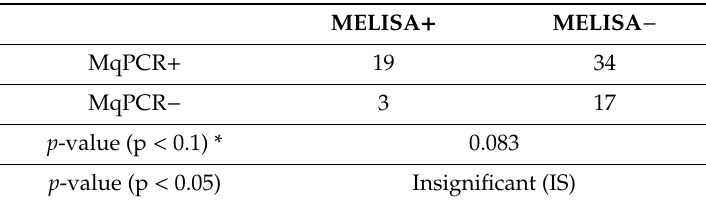
Table 5. Distribution of 73 BTMs based on the positivity / negativity status in MqPCR and MELISA tests and corresponding p -values.